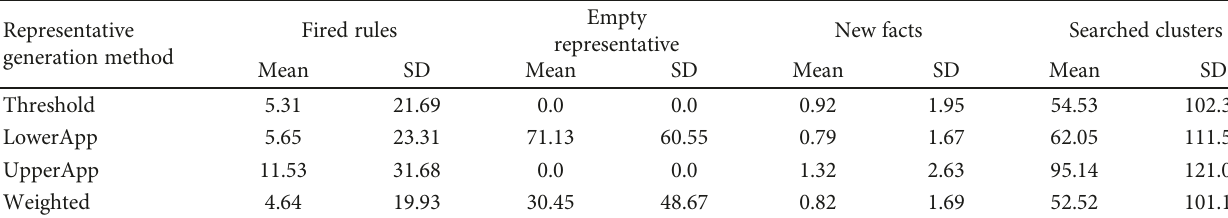
Table 4: Description of inference e ffi ciency vs. representative generation methods.